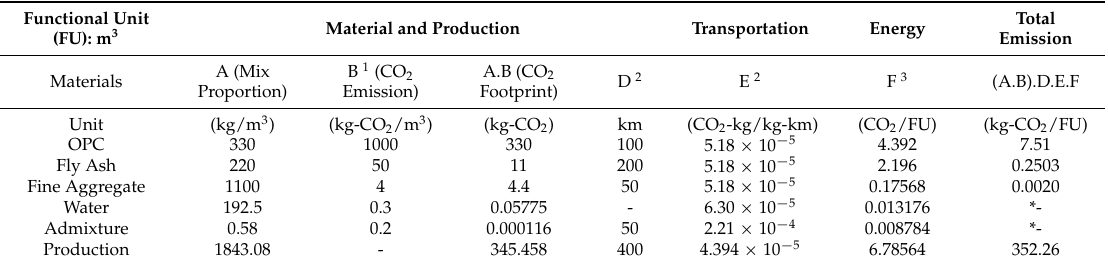
Table 10. Eco-points’ assessment for OPC + 40% fly ash compacting mortar.